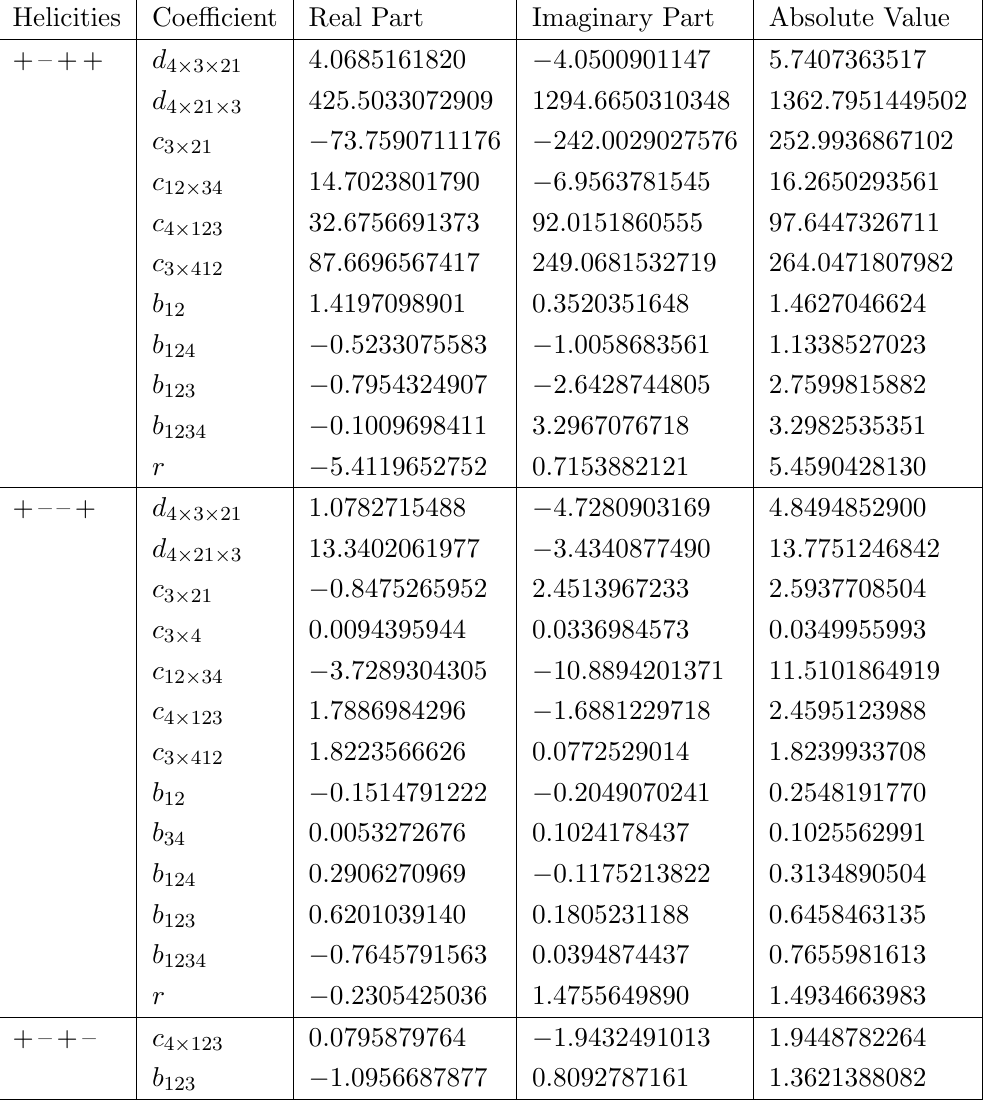
Table 8 . Numerical values of the needed coe(cid:14)cients and rational terms for + { + +, + { { + and + { + { helicities of the (cid:22) qqggh process at kinematic point, (D.1). Open